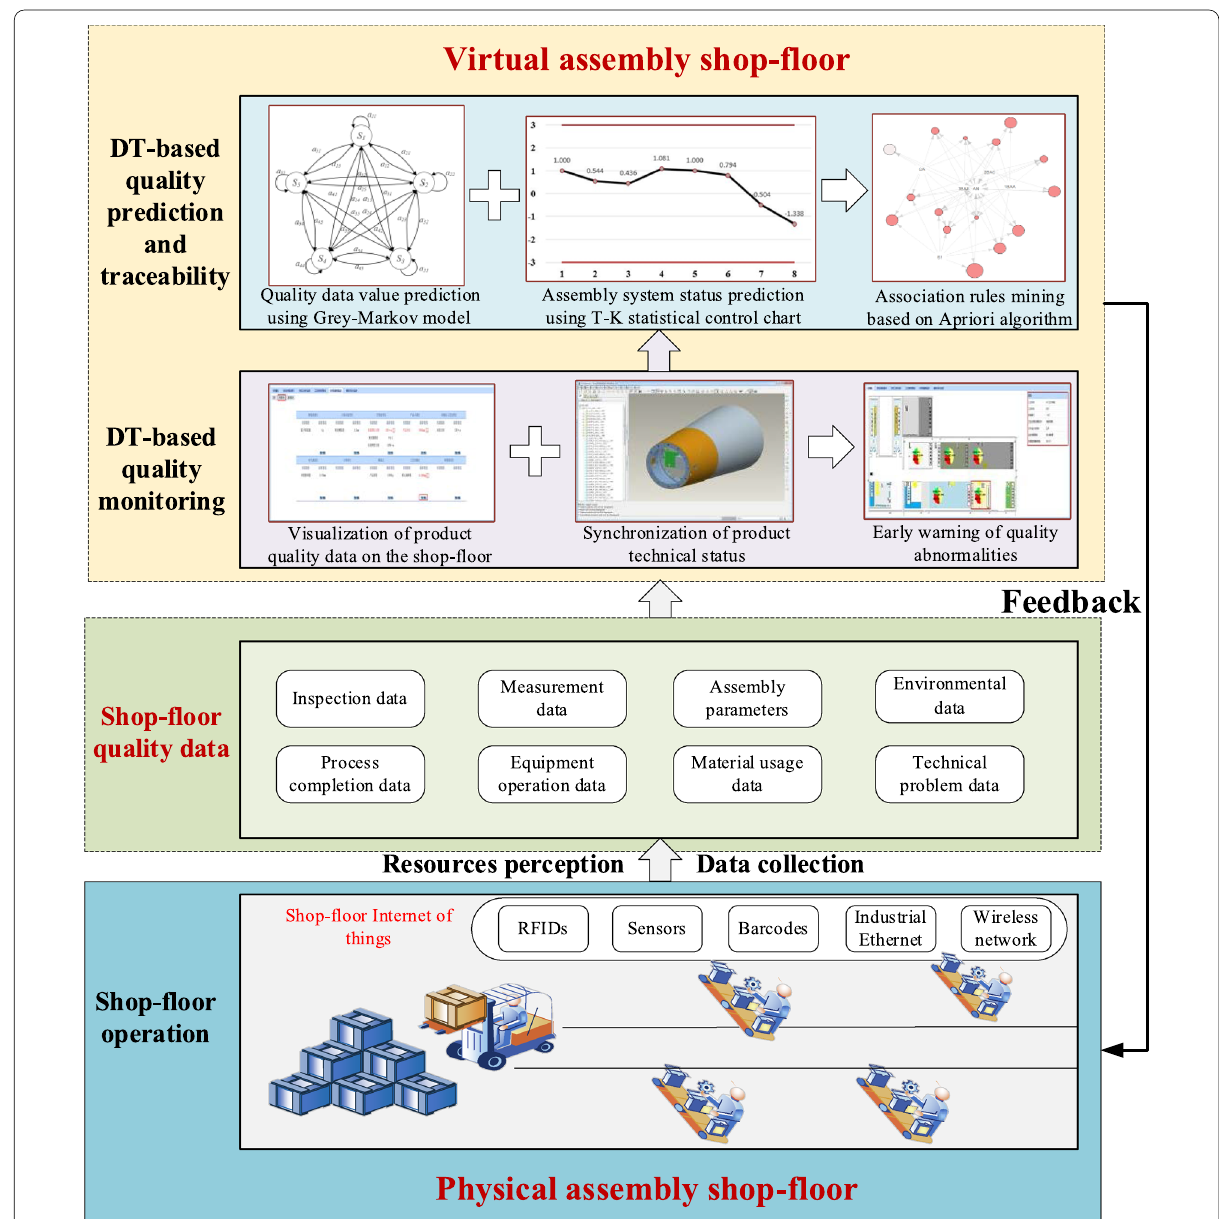
Figure 1 DT-based quality management framework for the assembly process of aerospace